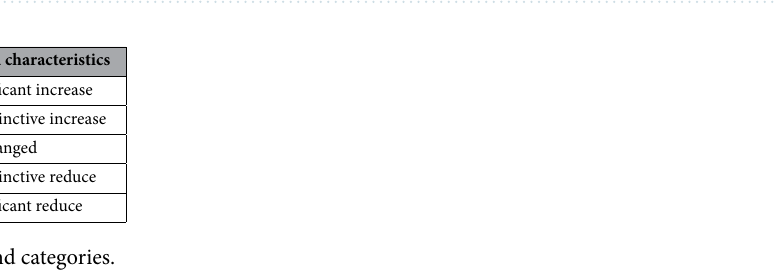
Figure 5. Spatial variation of seasonal snow cover. The maps were generated by ArcGIS 10.2, URL: http:// suppo rt. esri. com/ Produ cts/ Deskt op/ arcgis- deskt op/ arcmap/ 10-2- 2# overv iew.